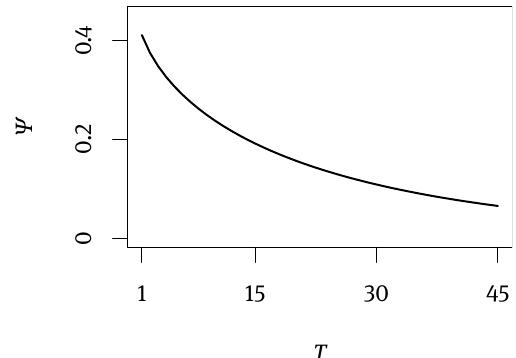
Figure 1: Probabilities of default for the equity model along with the maturity of the